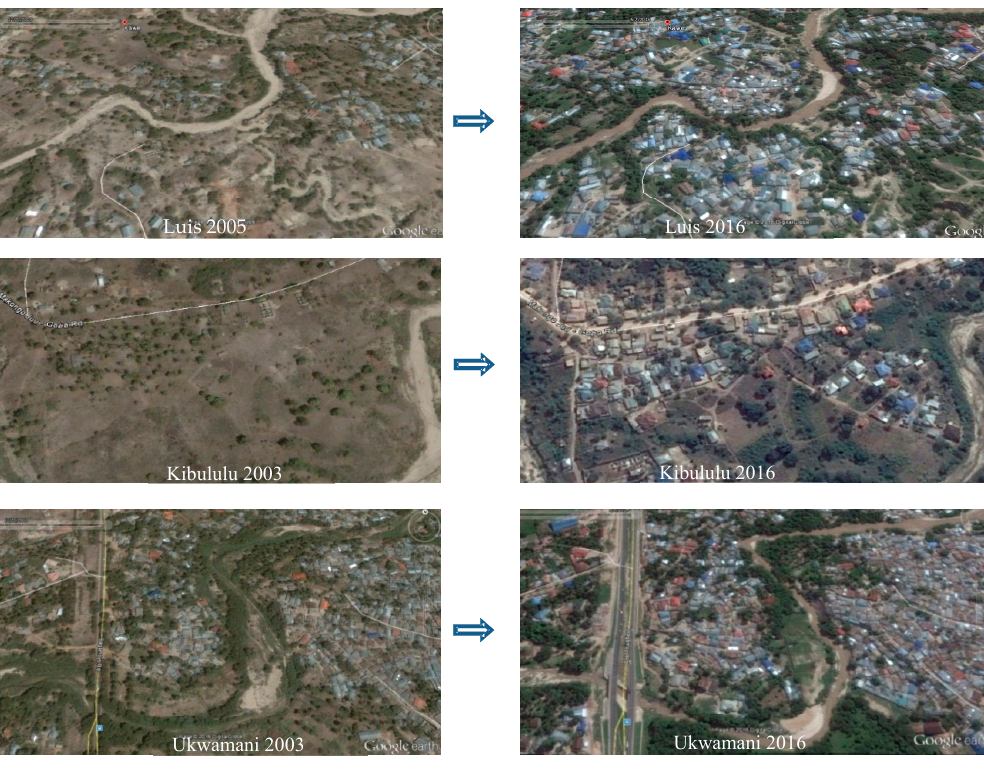
Figure 4. Urbanization trends from 2003 to 2016 in sub-case areas: Luis ( top row ); Kibululu ( middle row ); and Ukwamani ( bottom row ). Photos from: 2003 ( left column ); and 2016 ( right column ).